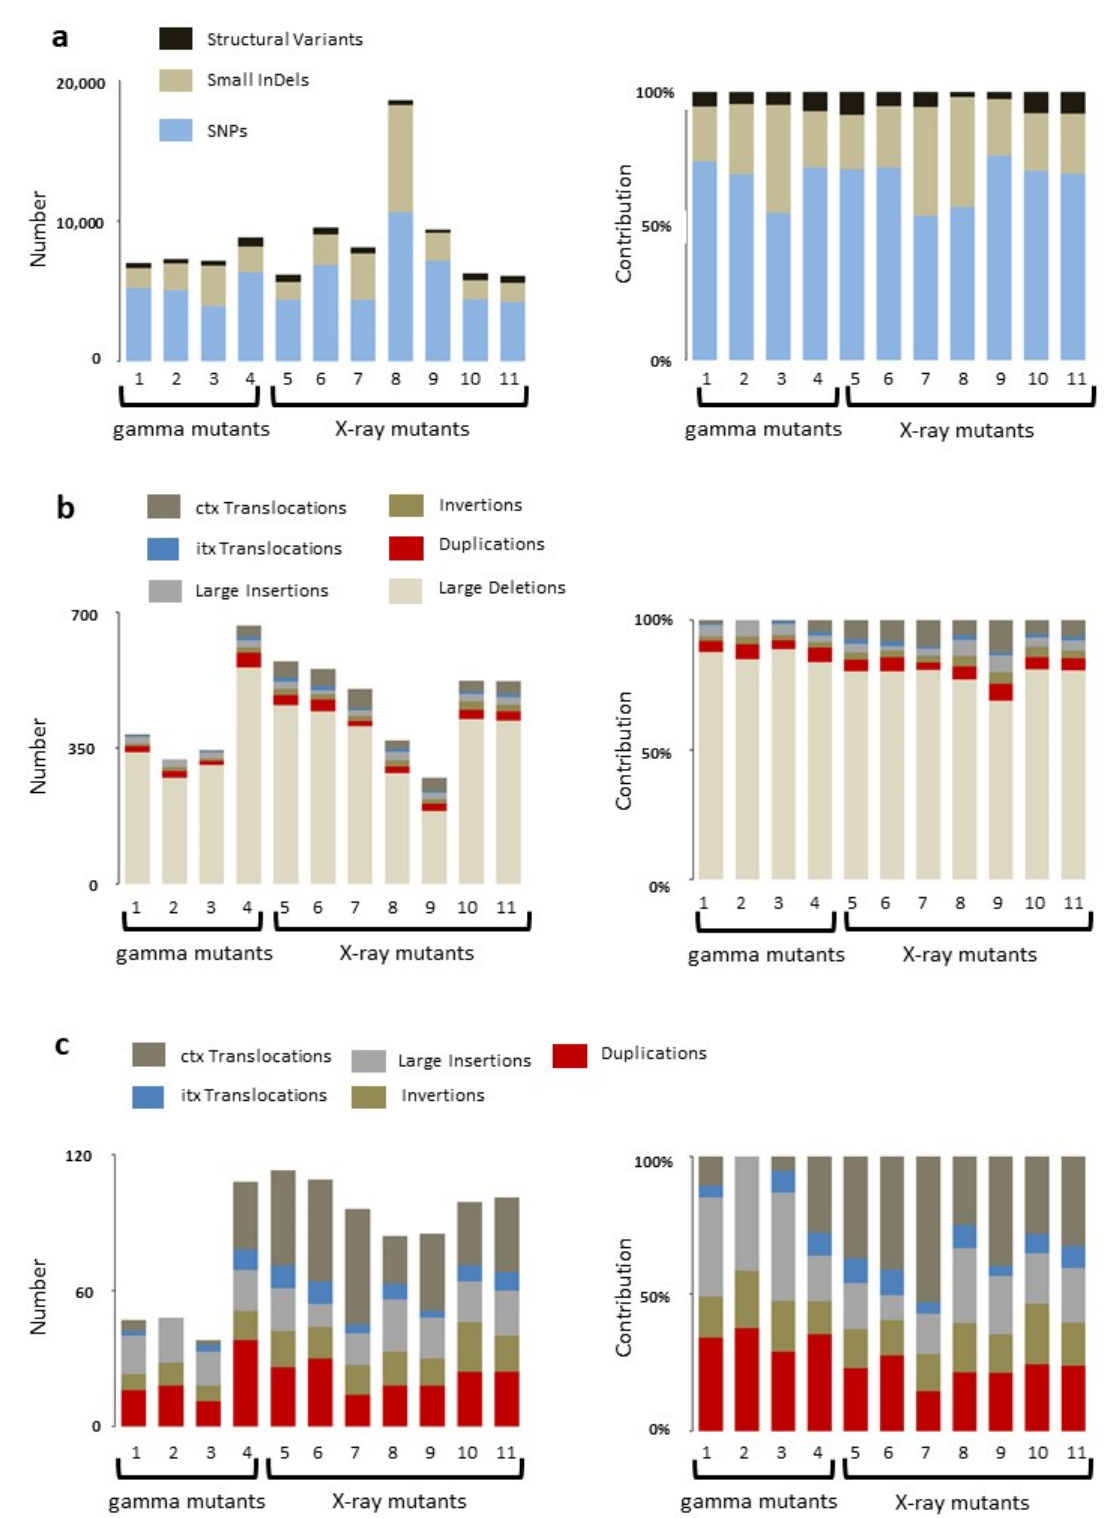
Figure 3. Distribution of variants in mutant lines: ( a ) total variation identified in gamma and X-ray mutagenized rice; ( b ) distribution of SVs; and ( c ) comparison of the least represented SVs in rice mutants.